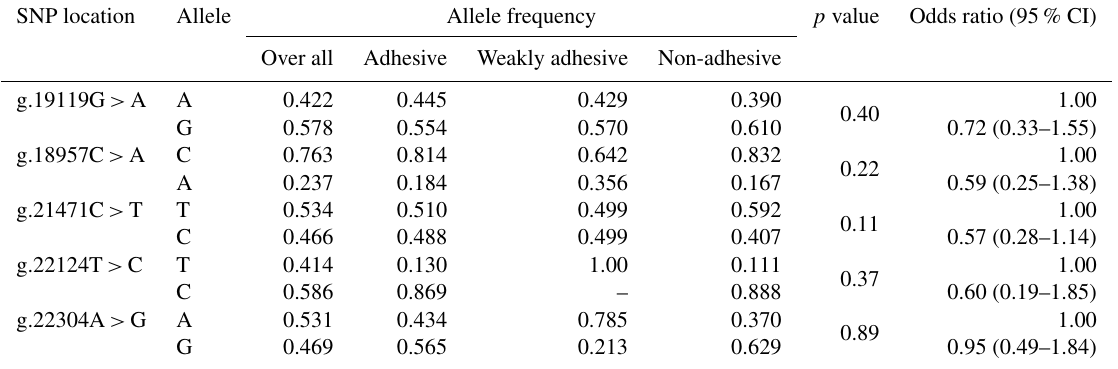
Table 3. Allele frequency distribution of SNPs in various adhesion phenotypes. SNP